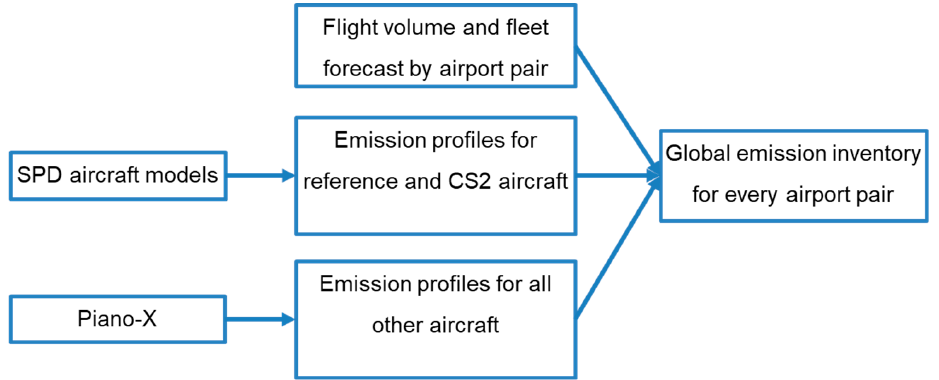
Figure 11. Overview of air transport system level emissions